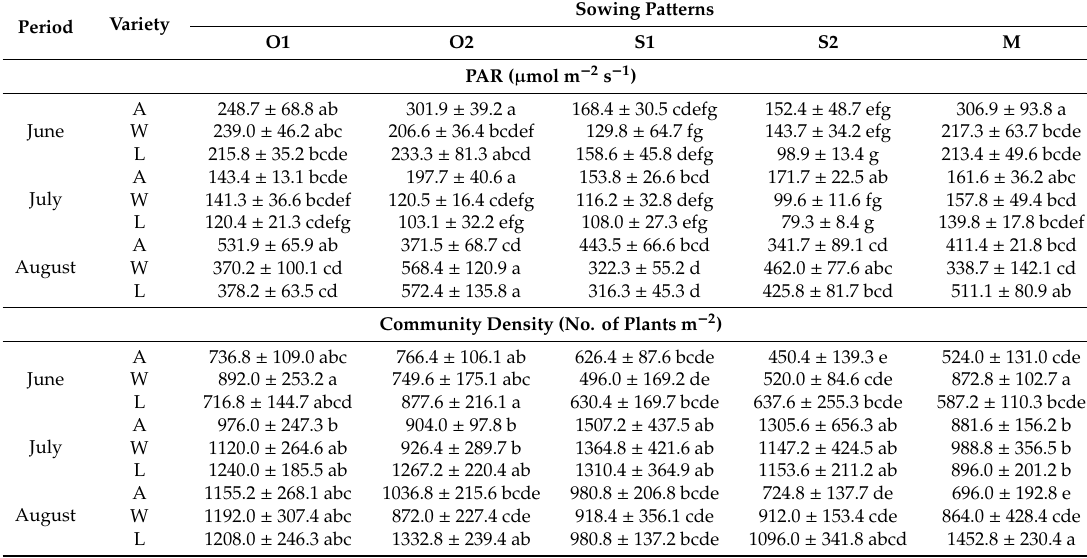
Table 4. Photosynthetically active radiation (PAR) and community density of all treatments during the growing